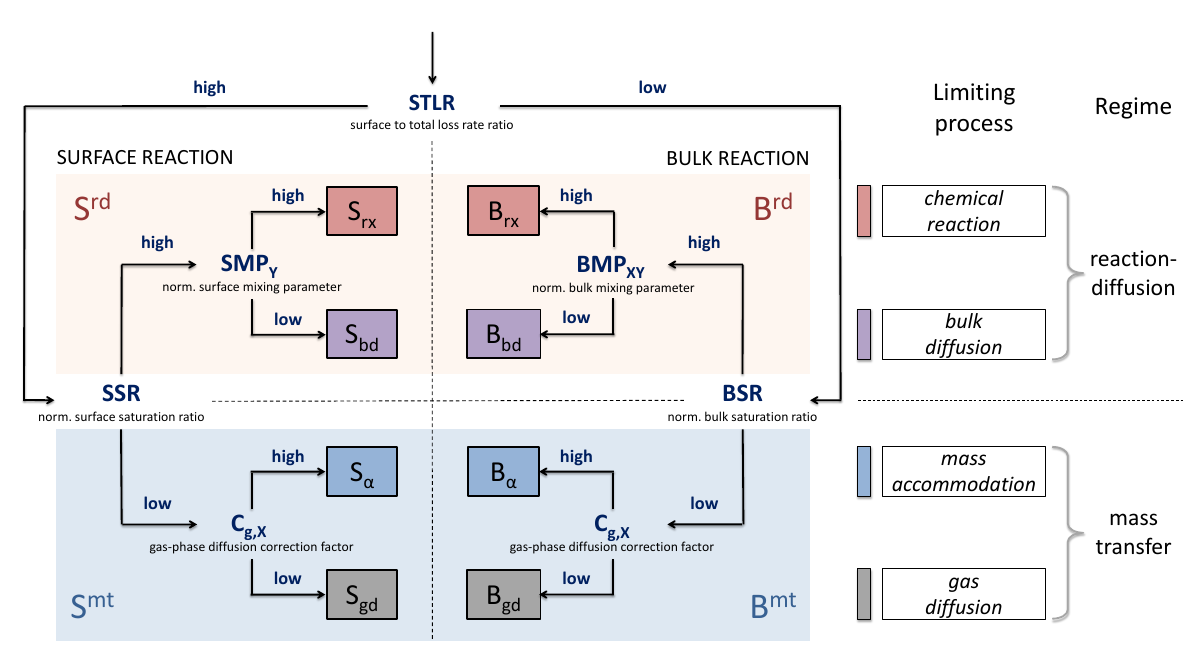
Fig. 4. Classification scheme for distinction of limiting cases. The decision process proceeds in three steps according to Sect. 2. Surface dominated cases (left half) and bulk dominated cases (right half) are distinguished in the first step by comparing the surface to the total loss rate (STLR). Reaction-diffusion systems (top half) and mass transfer-limited systems (bottom half) are distinguished in the second step by evaluating the saturation ratio (SR). In the last step mixing of the components is considered. Note that even though the scheme appears to be symmetric for surface and bulk reaction systems, the classification parameters differ between the left and the right side of the diagram in the second and third decision step. The reaction-diffusion and mass transfer regimes are indicated by large shaded boxes and the respective regime symbols are given in their outward corners.